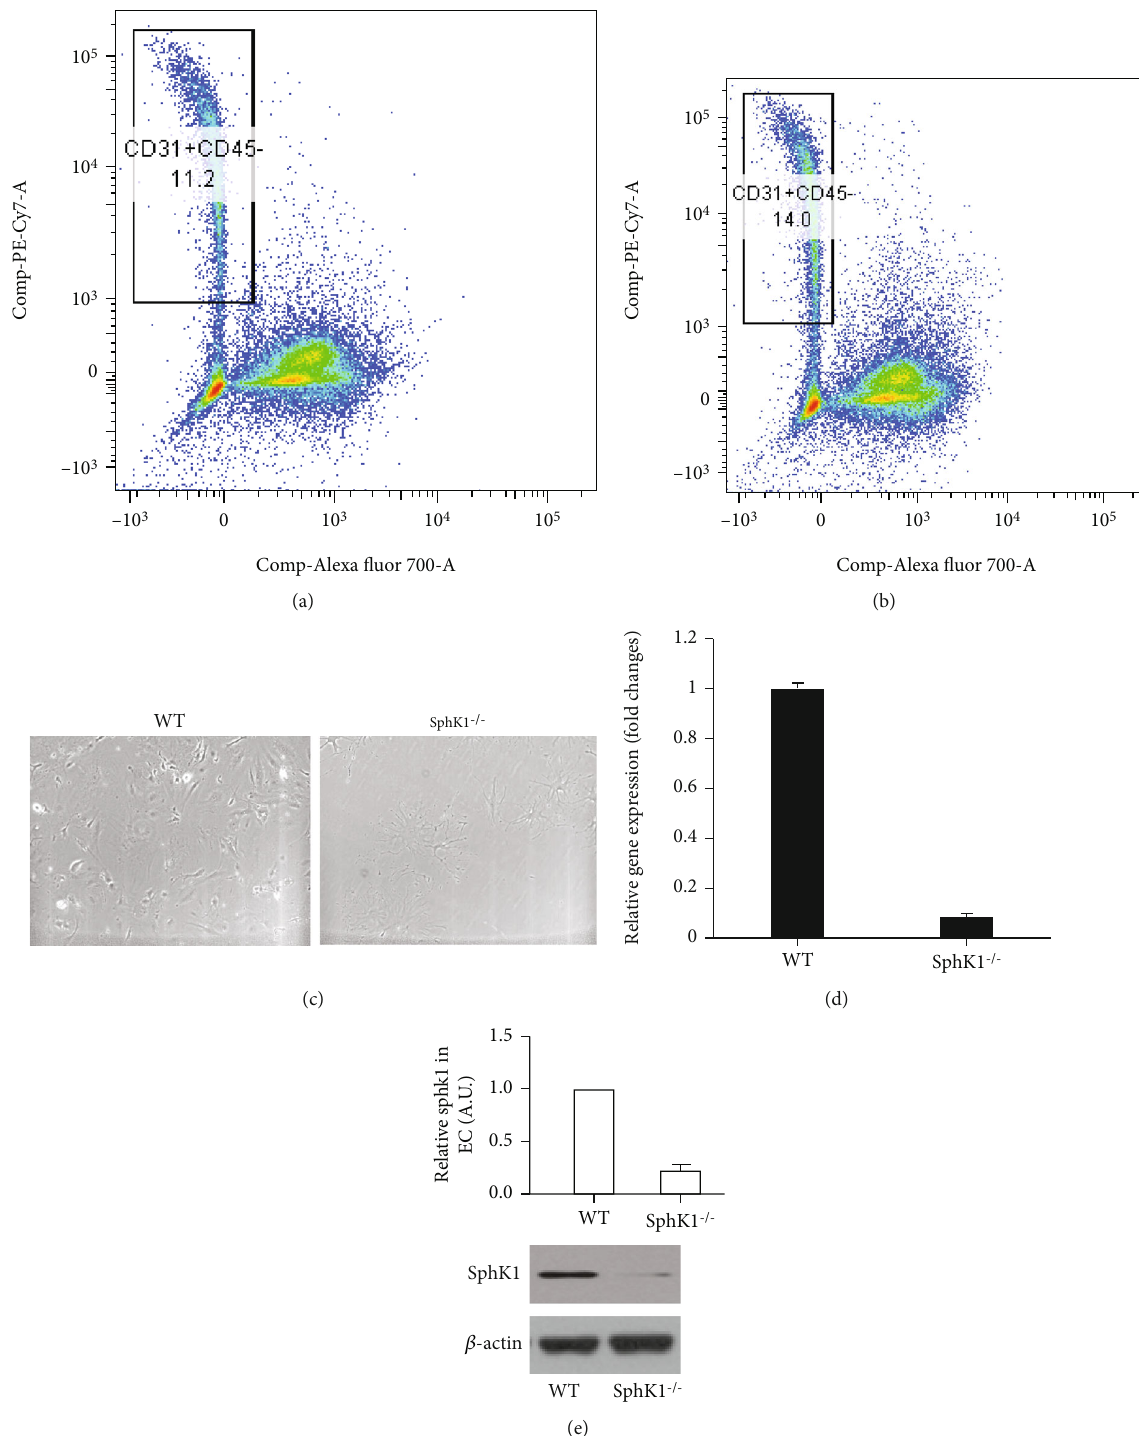
Figure 3: The endothelial cell isolation from WT and SphK1 -/- mouse lung and identi fi cation. The 8-week WT and SphK1 -/- mice were sacri fi ced, and lungs were harvested as described in Materials and Methods. (a) The endothelial cells of WT mouse lung were puri fi ed by fl ow cytometry (CD31 + /CD45 - ). (b) The endothelial cells of SphK1 -/- mouse lung were isolated and puri fi ed (CD31 + /CD45 - ). (c) The puri fi ed WT and SphK1 -/- endothelial cells were cultured on glass slides, and morphological properties were compared, including size, lamellipodia, and junctional properties. (d) qPCR and (e) western blot were performed to determine the sphingosine kinase 1 mRNA and protein level in puri fi ed endothelial